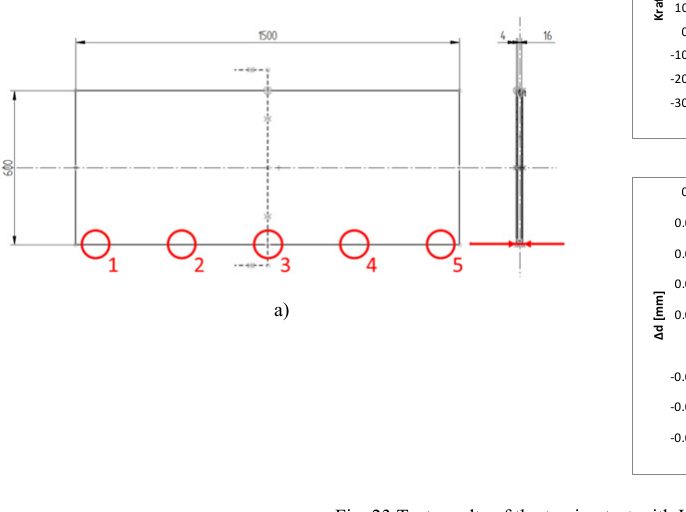
Fig. 23 Test results of the torsion test with IGUs Δ l = 25 mm a) geometry and position of measuring